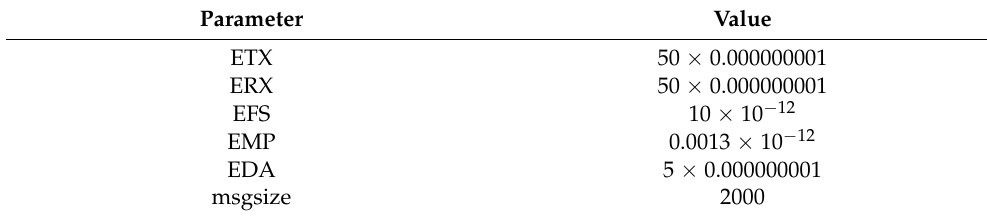
Table 5. Energy parameters and message size.